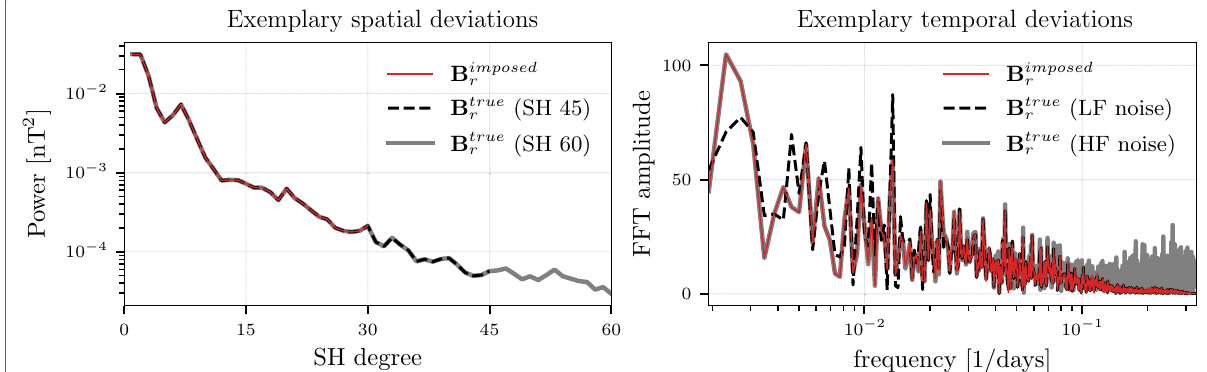
Fig. 9 Exemplary illustration of the spatial and temporal differences between the imposed and true fields studied in test case scenario B. The red line represents the unchanged imposed OIMF (identical to the previous scenario), whereas black and grey denote several different true OIMF used in this test case scenario. On the left, the power spectrum highlights spatial differences between imposed and two deviating true OIMF (shown at a fixed time step). On the right, the frequency spectrum exemplifies temporal differences between the imposed field and two other deviating true OIMF (shown at an exemplary fixed location)